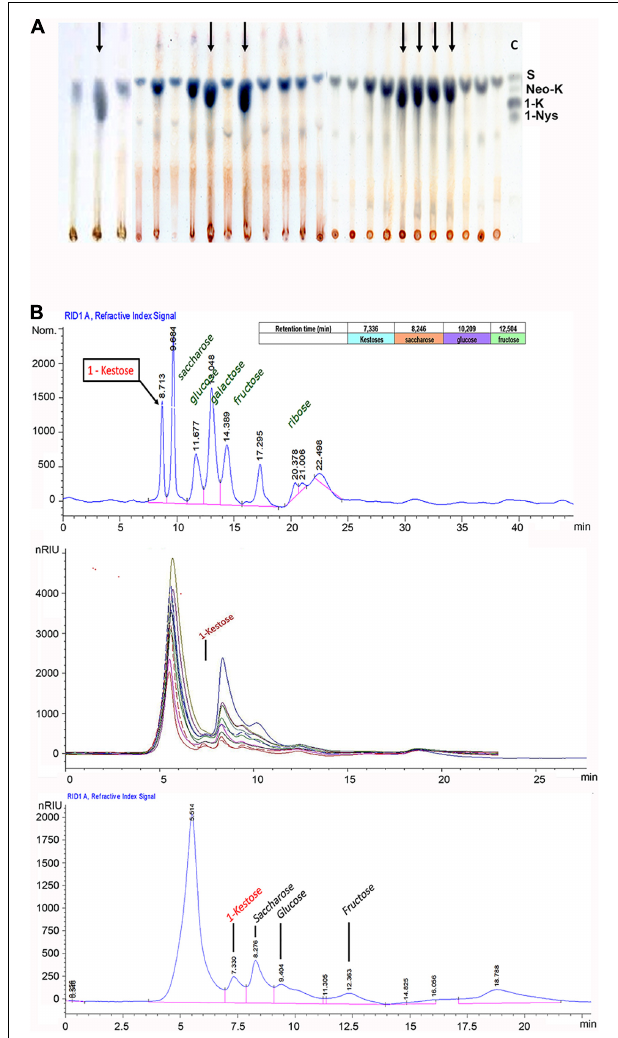
FIGURE 5 | High energy (fructan) transgenic events. (A) Thin-layer chromatography of different samples of soluble sugars from qPCR-positive plants of P. dilatatum . Black arrows indicate the possible presence of kestoses in the sample. As a control C, S = sucrose, neo-K = neo-kestose, 1-K = 1-kestose, and 1-Nys = 1-nystose standards were used. Source: Peralta Roa et al. (2015). (B) HPLC analysis of soluble sugars from qPCR-positive plants. Run of fructose, glucose, ribose, sucrose, saccharose, and kestose standards (upper). Sugar samples of transgenic P. dilatatum (medium). Run of a single qPCR-positive sample of P. dilatatum (lower). Source: Peralta Roa et al.